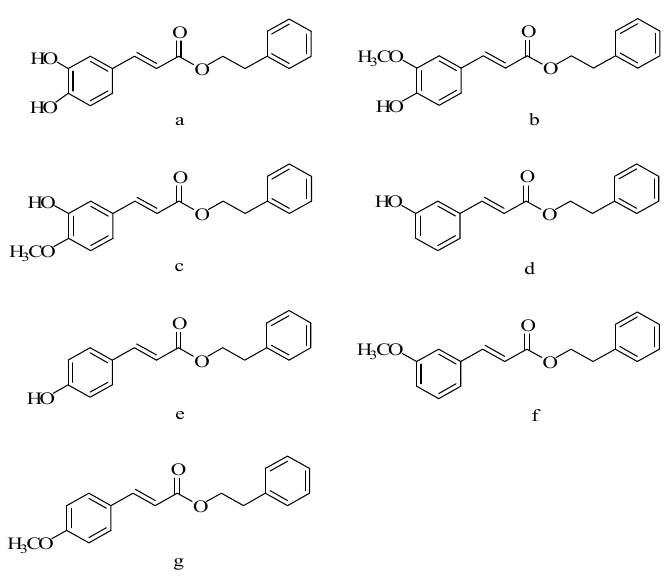
Figure 13. The structure of CAPE derivatives.